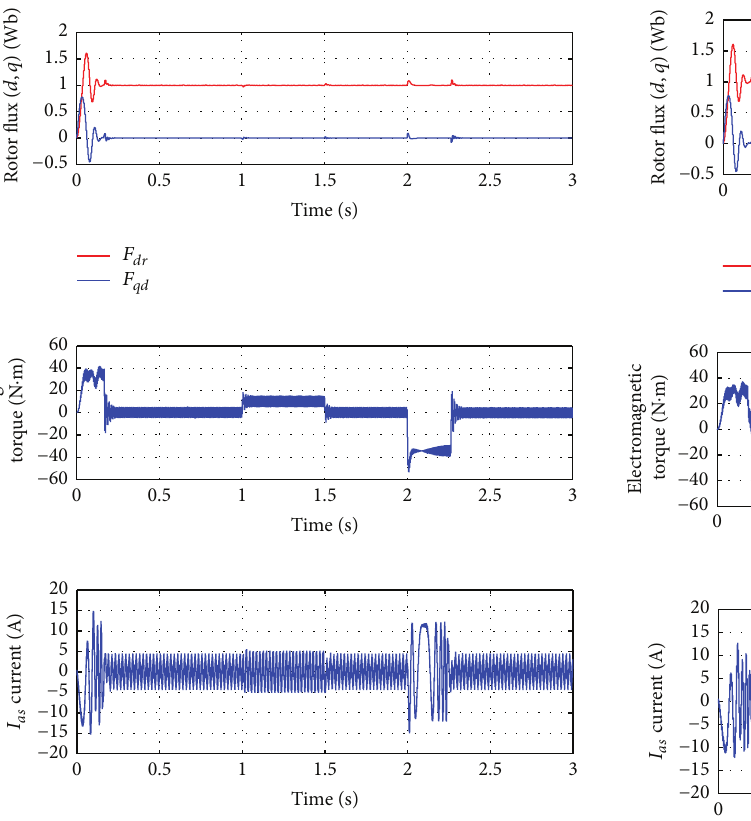
Figure 5: Control by fuzzy controller (PI).